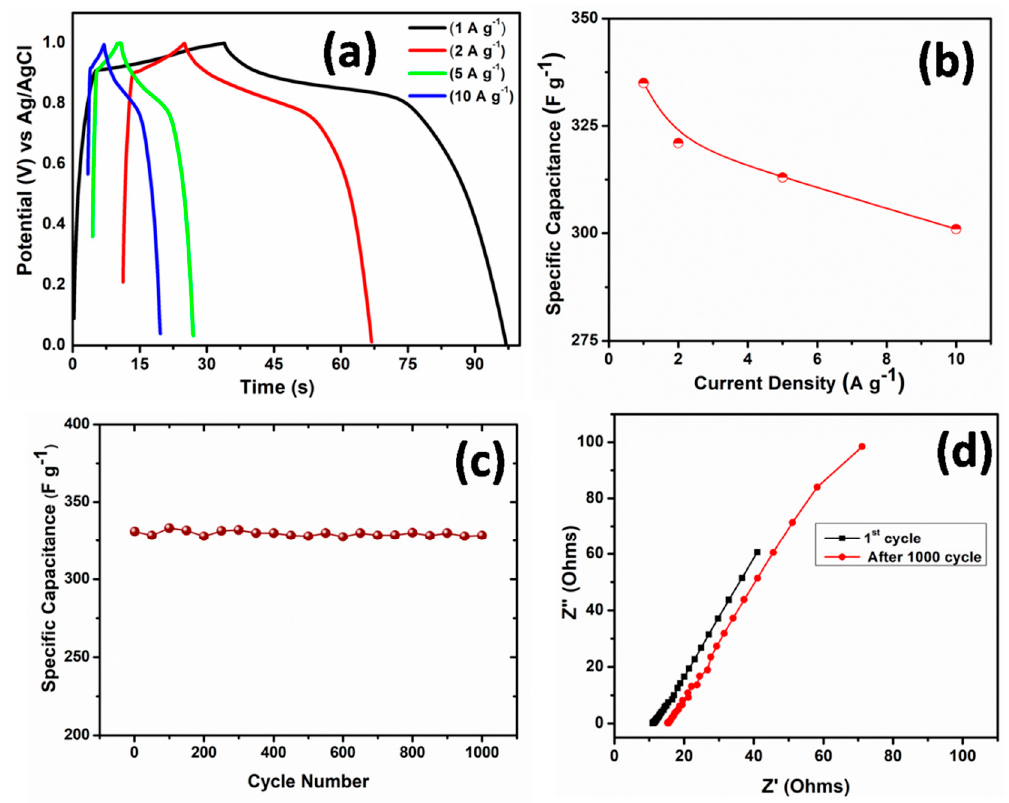
Figure 7. ( a ) Charge-Discharge curves of ZnO nanorods electrode based asymmetrical supercapacitor. ( b ) Variation of specific capacitance of ZnO nanorods electrode with di ff erent current density. ( c ) Cyclic performance of ZnO nanorods at a current density of 1 A g − 1 . ( d ) Nyquist plots of ZnO nanorods electrode for 1st and after 1000th